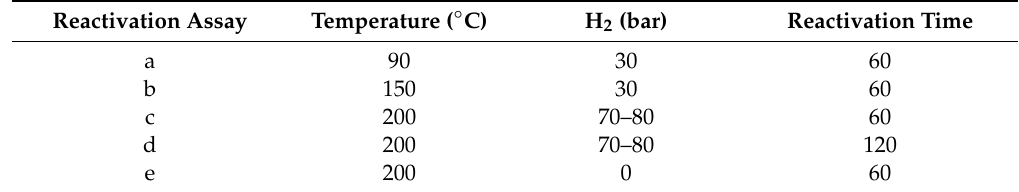
Table 10. Assays of catalyst regeneration at 90, 150, and 200 ◦ C, with / without a hydrogen atmosphere. Reactivation Assay Temperature ( ◦